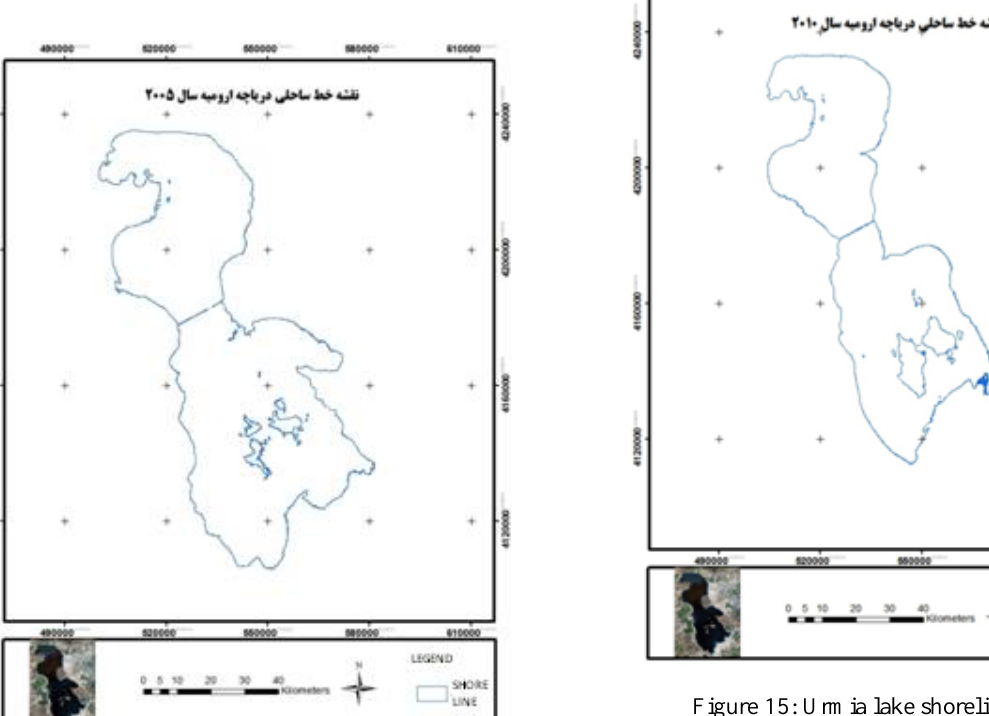
Figure 15: Urmia lake shoreline in